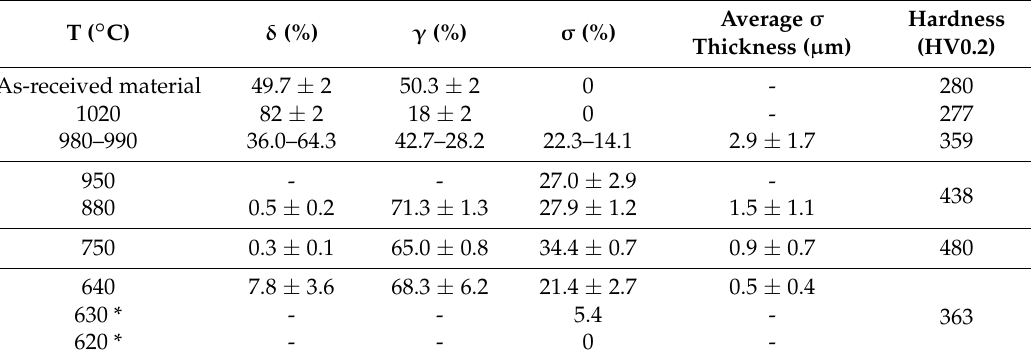
Table 2. Phase fractions, σ thickness and hardness.